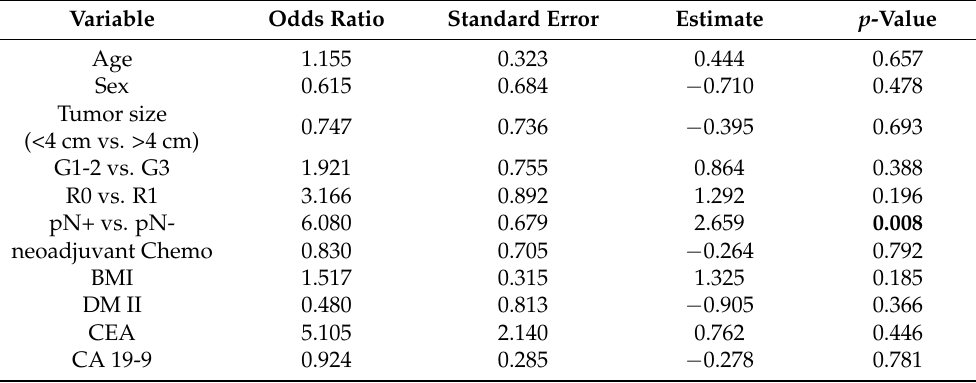
* Fisher’s exact test for categorical variables and students t -test for continuous variables. Using a logistic regression model to assess the potential impact of different variables on PNI, only lymph node metastasis was a significant predictor of PNI (OR: 6.4; p < 0.01, Table 3). A total of 20% (8/40) of patients in the Pn0 group and 10.5% (58/531) of patients in the Pn1 group received preoperative chemotherapy. Logistic regression indicated no significant impact of preoperative chemotherapy on PNI. Other preoperative parameters, such as body mass index (BMI), history of type I or type II diabetes mellitus and medica- tion with selective or nonselective betablockers, were evaluated for their impact on PNI. There was a significant difference between the BMI of the Pn0 and Pn1 group ( p = 0.044). CEA levels between Pn0 and Pn1 group also displayed significant differences ( p < 0.001). However, according to the logistic regression analyses, there was no significant impact of these preoperative factors on PNI. Table 3. Logistic regression analysis of variables and their impact on